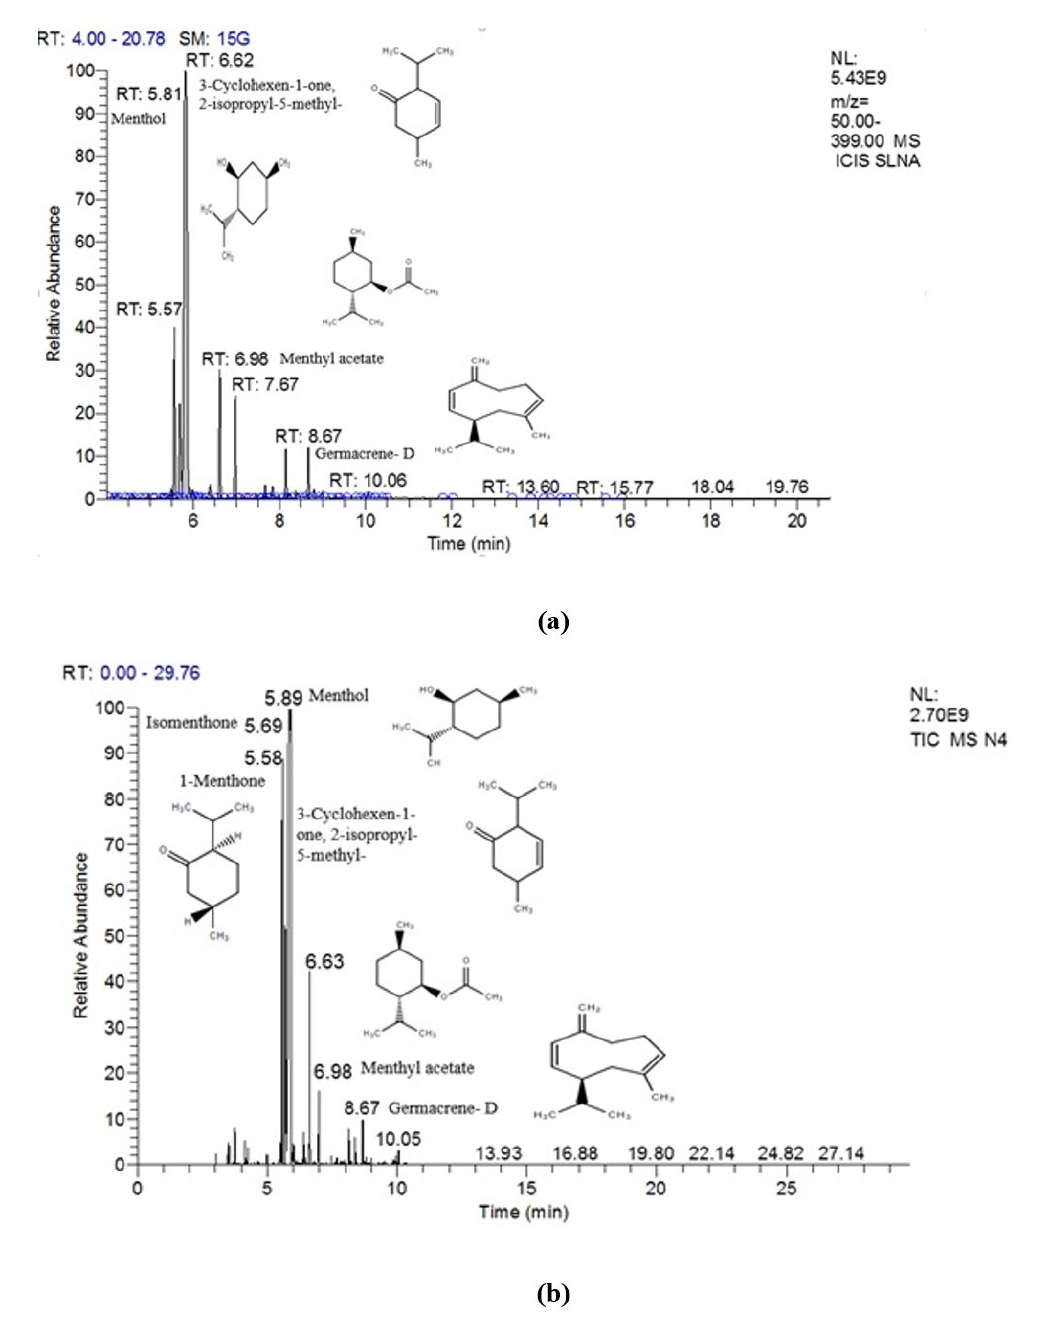
Fig. 1. GC-MS chromatograms of essential oil of M. piperita obtained from leaves in the month of April (a) and July